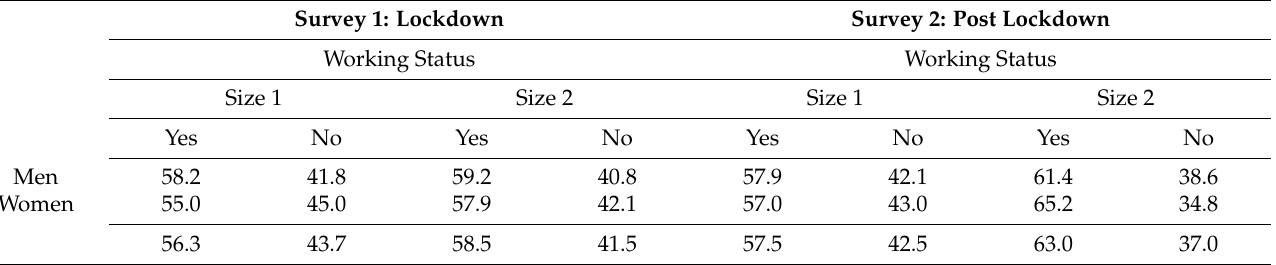
Table 6. Labor status distributions by gender in each of the groups analyzed.